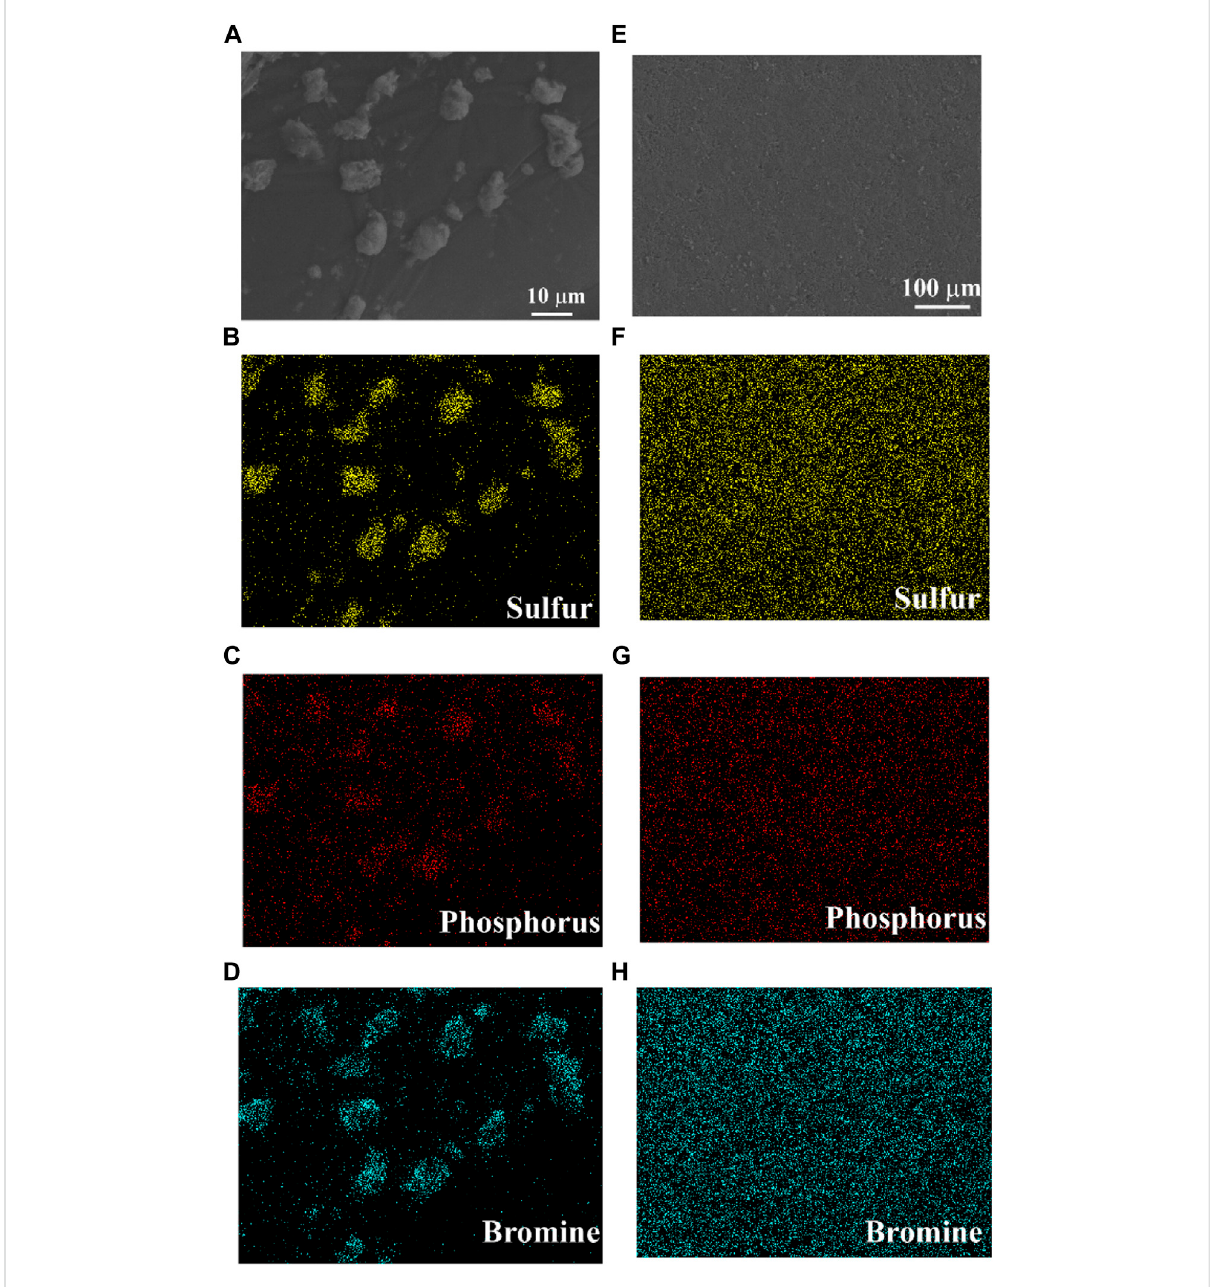
(Figure 4F,G,H), which indicates that no elements aggregate during the solid-state reaction